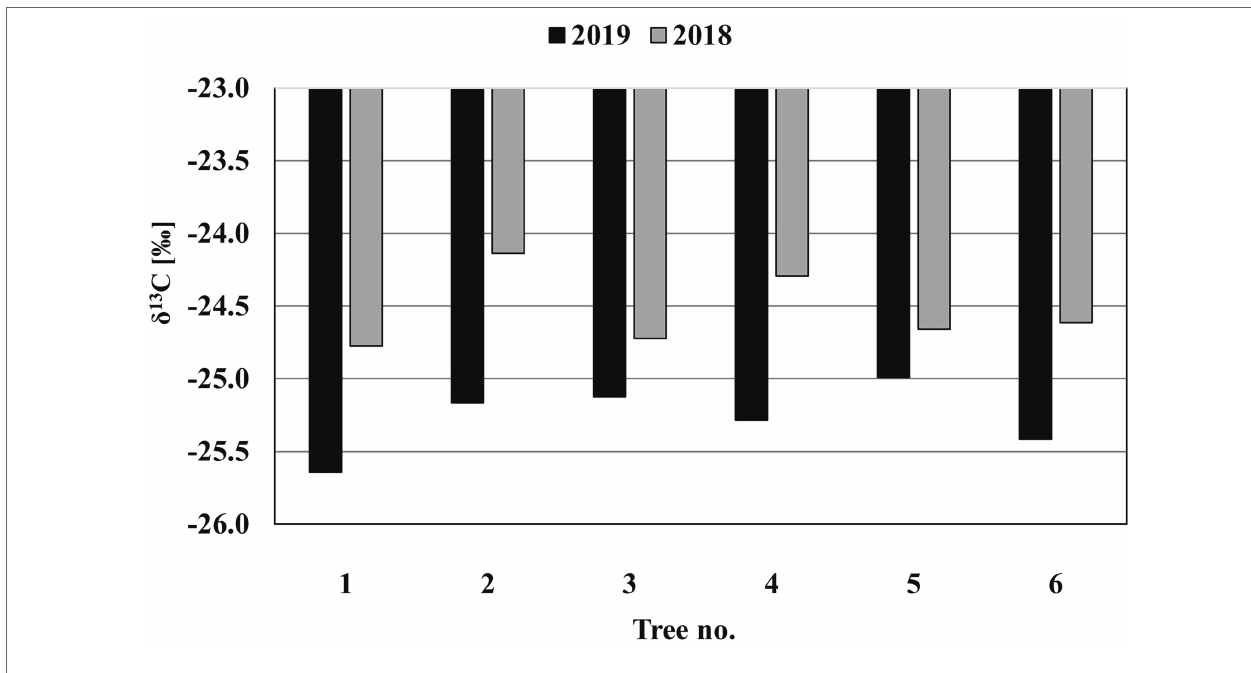
FIGURE 6 | The δ 13 C isotope results of the two rings formed before (2018) and after (2019) the pinnings in the stems of M.